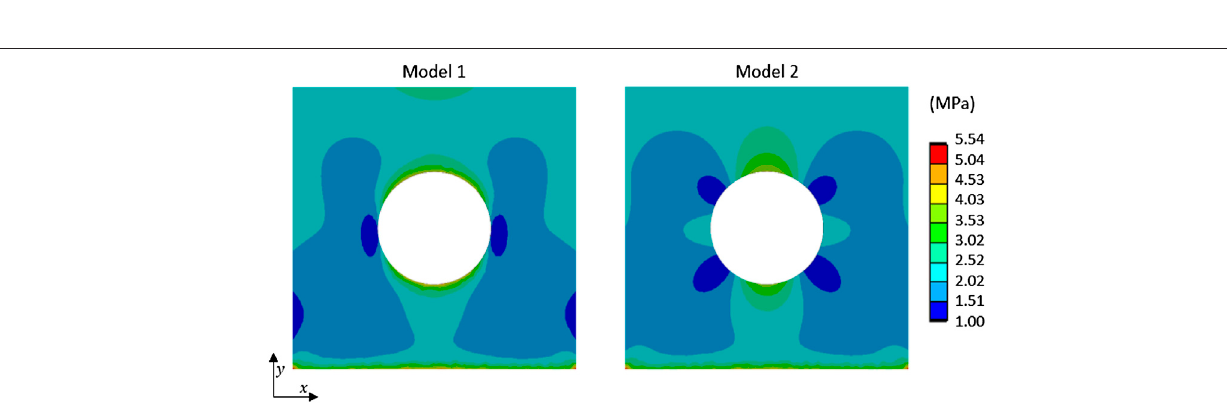
Frontiers in Bioengineering and Biotechnology |